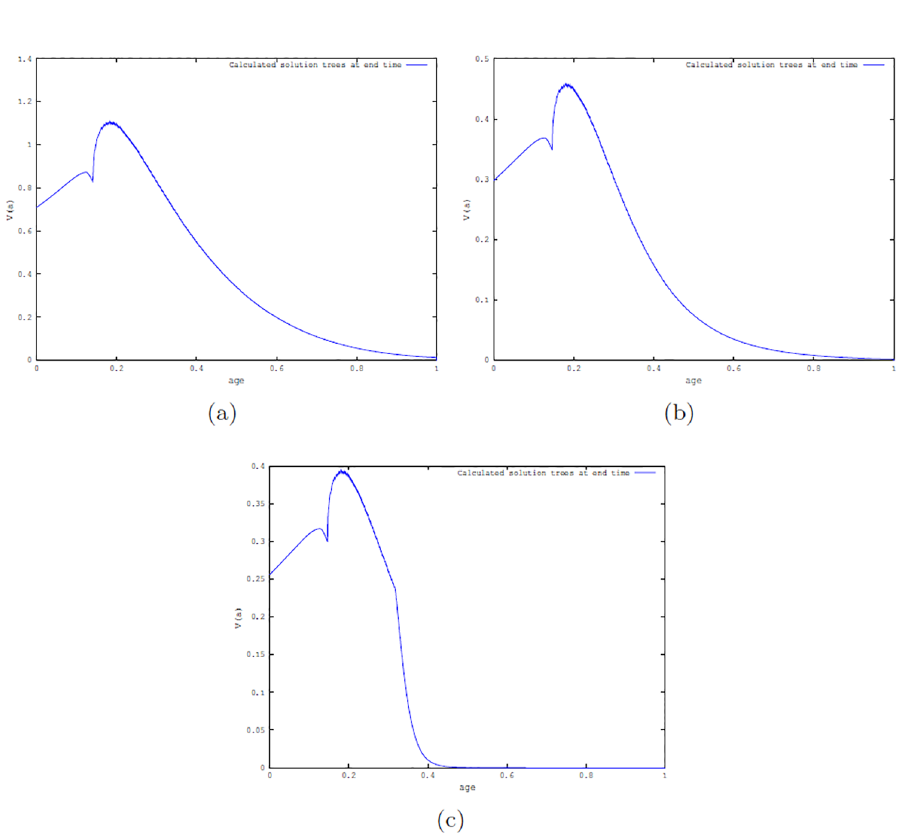
Fig 4. Number of trees at the end time t = 1 (i.e., at 350 years) obtained by simulation of optimal control problem P1 with u max = 10 and ω 1 = 1. (a): When there are no beetles; (b): When beetles are in endemic state; and (c): When beetles are in epidemic states.